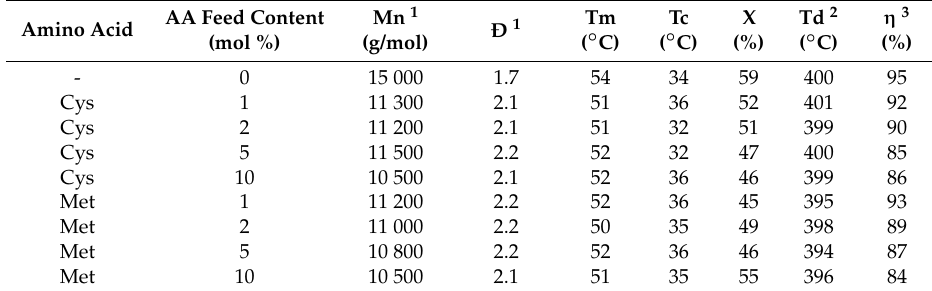
Table 1. Results obtained from the direct polymerization of ε -caprolactone (CL) with the two unmodified amino acids (methionine and